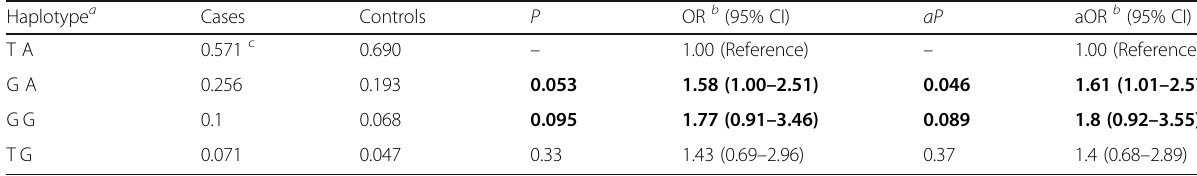
Table 5 IKZF-1 haplotypes distributions in cases and controls Haplotype a